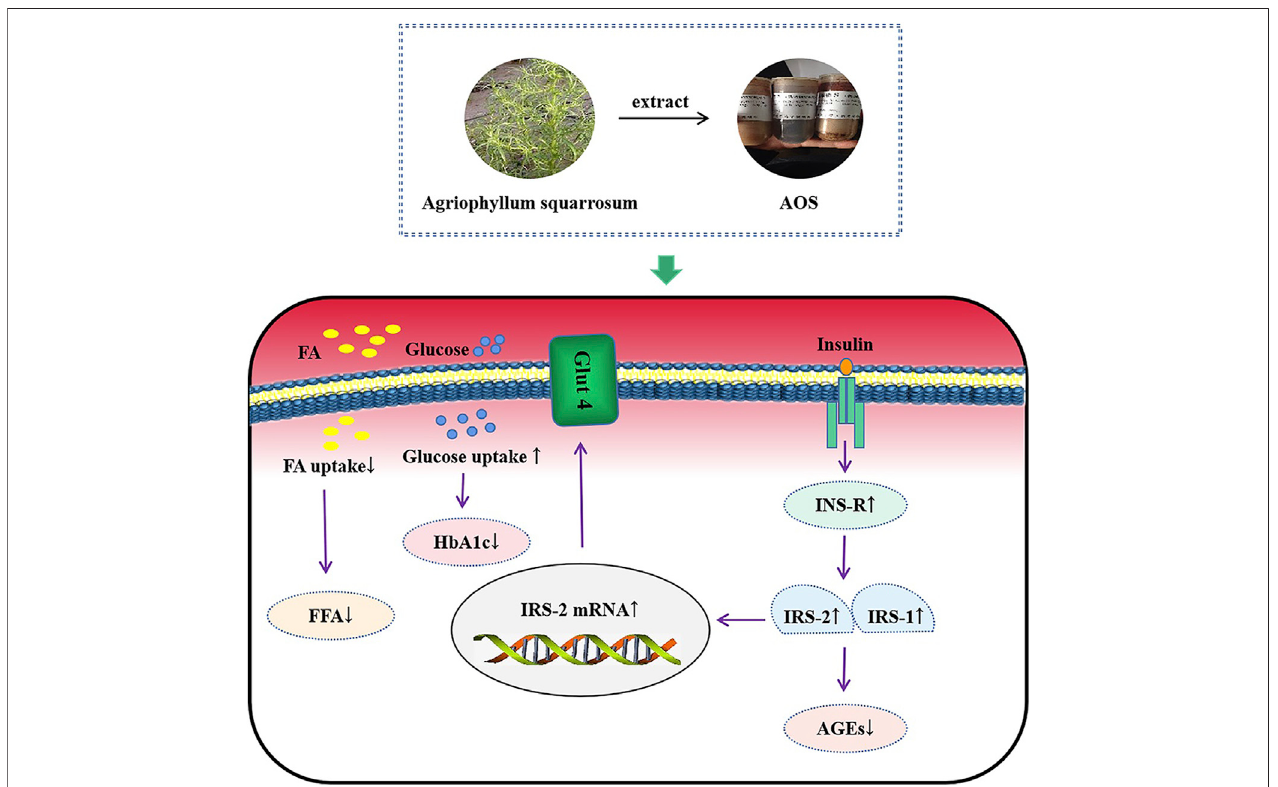
FIGURE 10 | The mechanism diagram of AOS alleviated diabetic insulin resistance in db/db mice and high glucose-induced MIN6 cells.